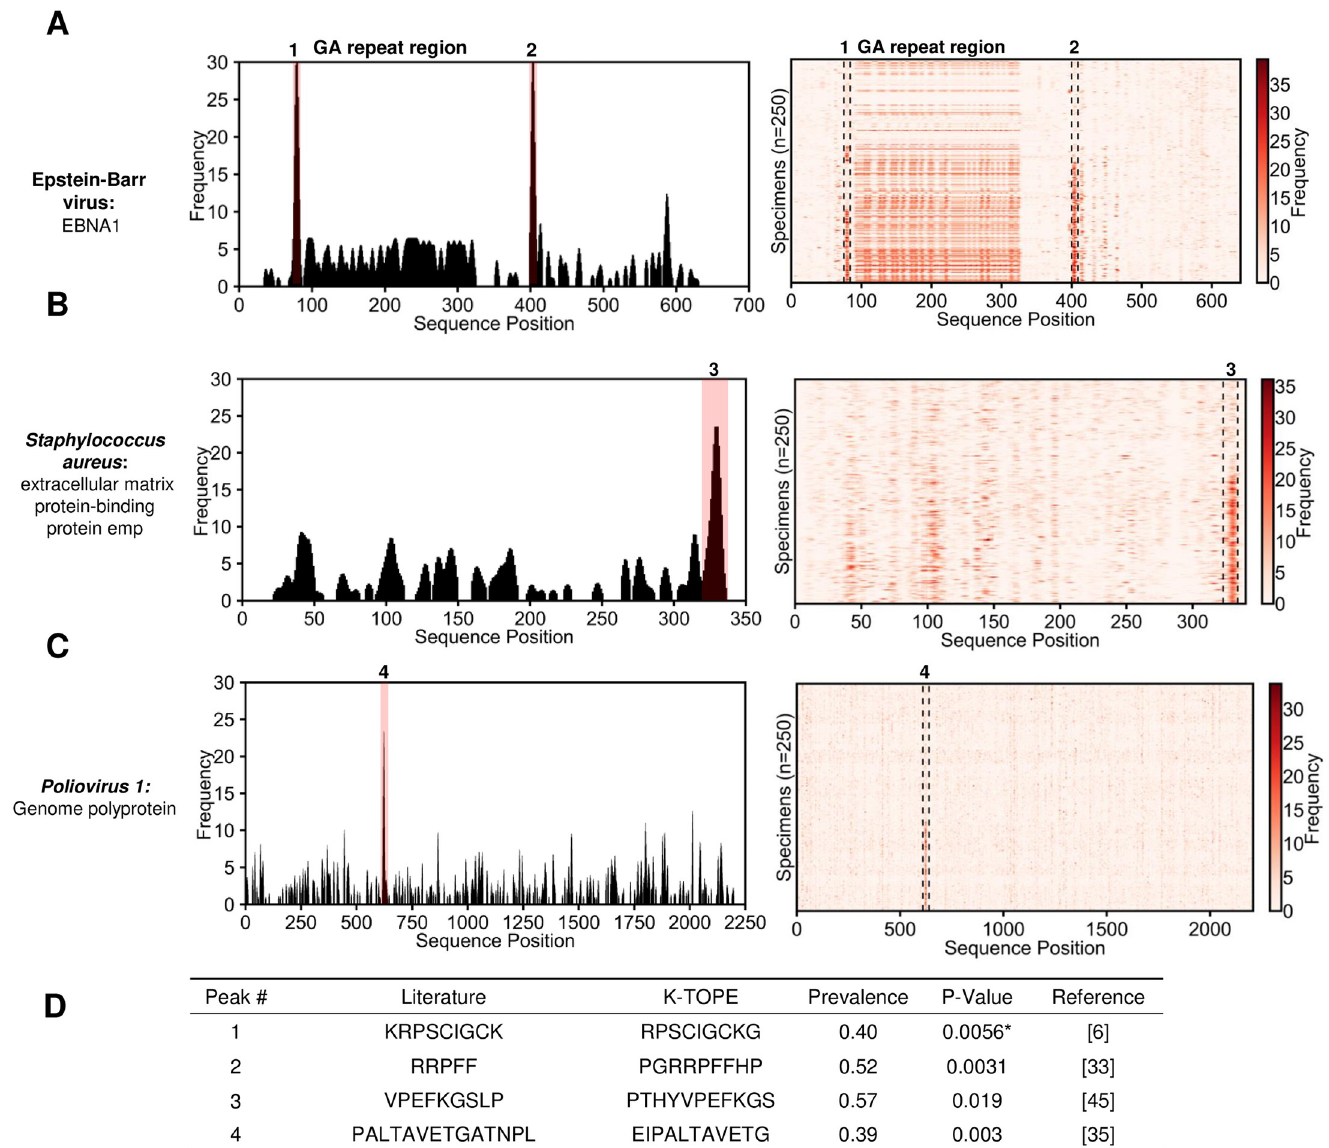
Fig 4. Epitopes predicted through proteome searches were validated using literature-reported epitopes. In (A), (B), and (C), histograms are shown for typical individual specimens (epitopes with percentiles > 99.7% are highlighted in pink). To the right of the histogram is a heat map for 250 specimens. For (A), there is a region of antigenic GA-repeats from positions 100–350. The table in (D) provides the statistical significance of agreement between literature epitopes and K-TOPE epitopes for the labeled peaks in (A), (B), and (C). The UniProt accessions used for this analysis were P03211 for EBNA1, Q8NXI8 for extracellular matrix protein- binding protein emp, and P03300 for Poliovirus 1 Genome Polyprotein. Statistical tests where epitopes with > 50% GA content were removed are denoted by an asterisk “ � ”. All predicted epitopes had p-values below